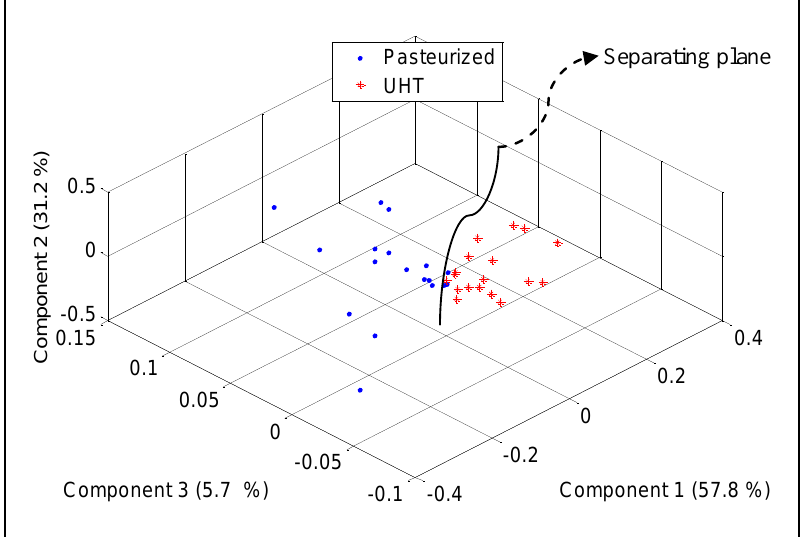
Figure 12. PCA plot of UHT and pasteurized milk.